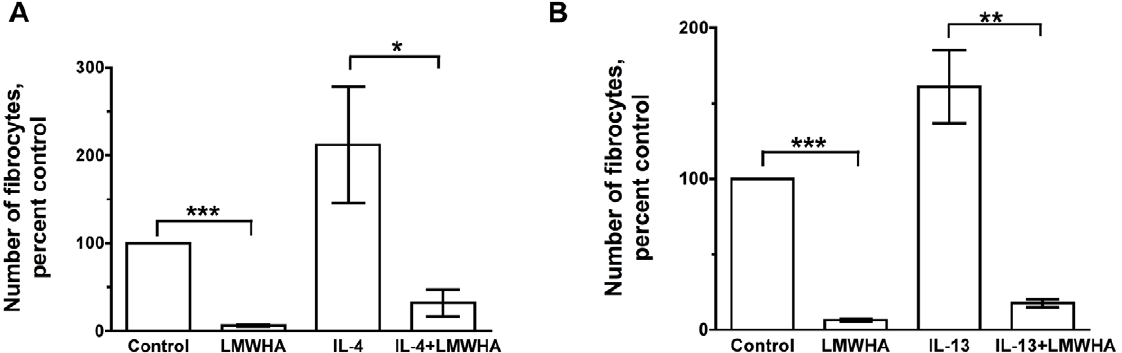
Figure 11. LMWHA inhibits IL-4 or IL-13-induced fibrocyte differentiation. Human PBMC were cultured in ( A ) SFM, SFM with 1 ng/ml IL-4, SFM with 300 m g/ml LMWHA, or SFM with 1 ng/ml IL-4 and 300 m g/ml LMWHA, or ( B ) SFM, SFM with 1 ng/ml IL-13, or SFM with 1 ng/ml IL-13 and 300 m g/ml LMWHA. After 5 days, the cells were air dried, fixed, stained, and the number of fibrocytes was counted. The results are mean 6 SEM of percent control (n=3 separate experiments). The number of fibrocytes per 2.5 6 10 5 PBMC in controls from the 3 donors was 900, 1520, and 431. * indicates p , 0.05, ** p , 0.01, and *** p , 0.001 compared to control as determined by t-test. Using the non-parametric Mann Whitney two-tailed t- test, there is no significant difference among control, 300 m g/ml LMWHA, 1 ng/ml IL-4, 1 ng/ml IL-13, the combination of 300 m g/ml LMWHA and 1 ng/ml IL-4, or the combination of 300 m g/ml LMWHA and 1 ng/ml IL-13. Using the non-parametric Mann Whitney one-tailed t-test, 300 m g/ml LMWHA significantly decreases the number of fibrocytes when compared to control with p , 0.05. Also, the combination of 300 m g/ml LMWHA and 1 ng/ml IL-4 significantly decreases the number of fibrocytes when compared to 1 ng/ml IL-4 with p , 0.05. The combination of 300 m g/ml LMWHA and 1 ng/ml IL-13 also significantly decreases the number of fibrocytes when compared to 1 ng/ml IL-13 with p ,